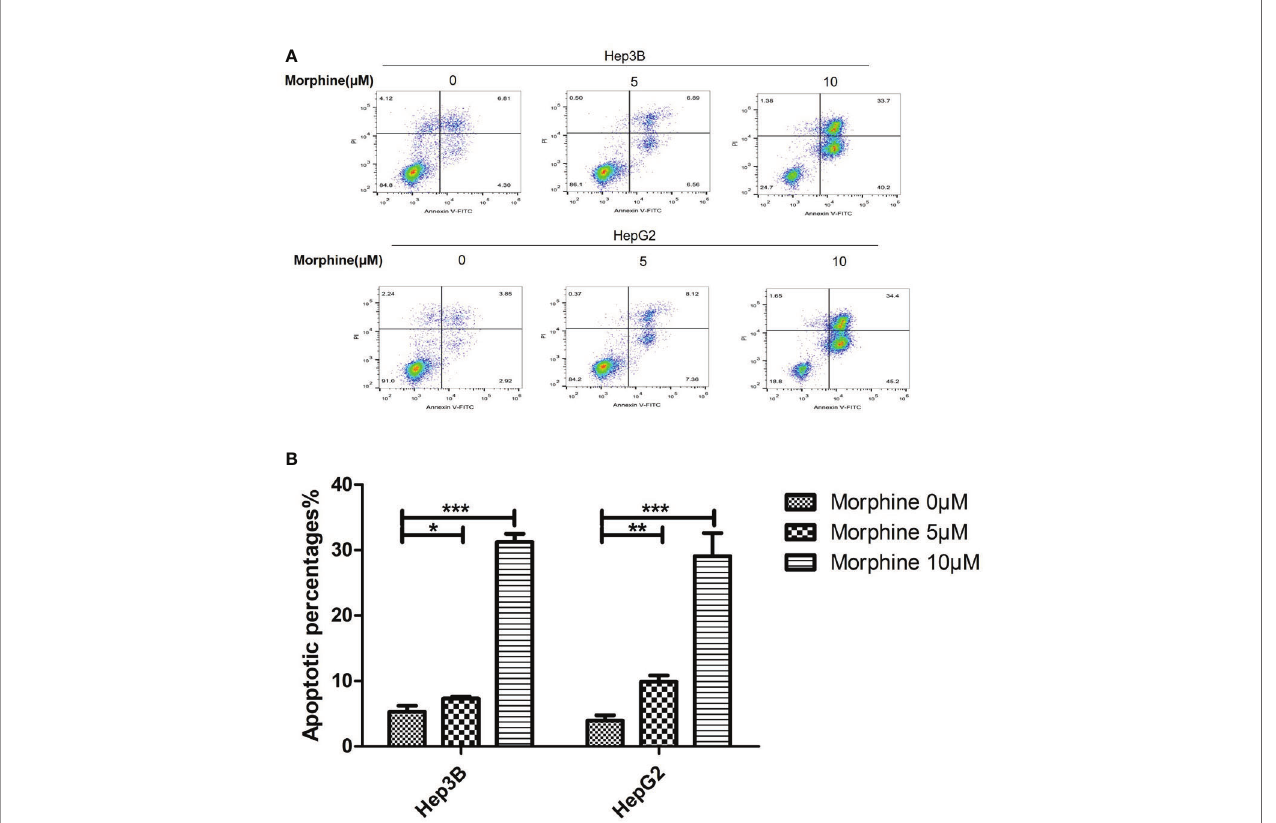
FIGURE 2 | Morphine promotes the apoptosis of Hep3B/HepG2 cells in vitro . (A) Representative image of fl ow cytometry analysis of Annexin V and Propidium iodide as a measure of apoptosis and (B) quantitative analysis of apoptosis in Hep3B/HepG2 cells exposed to morphine for 24h. Data are expressed as mean ±